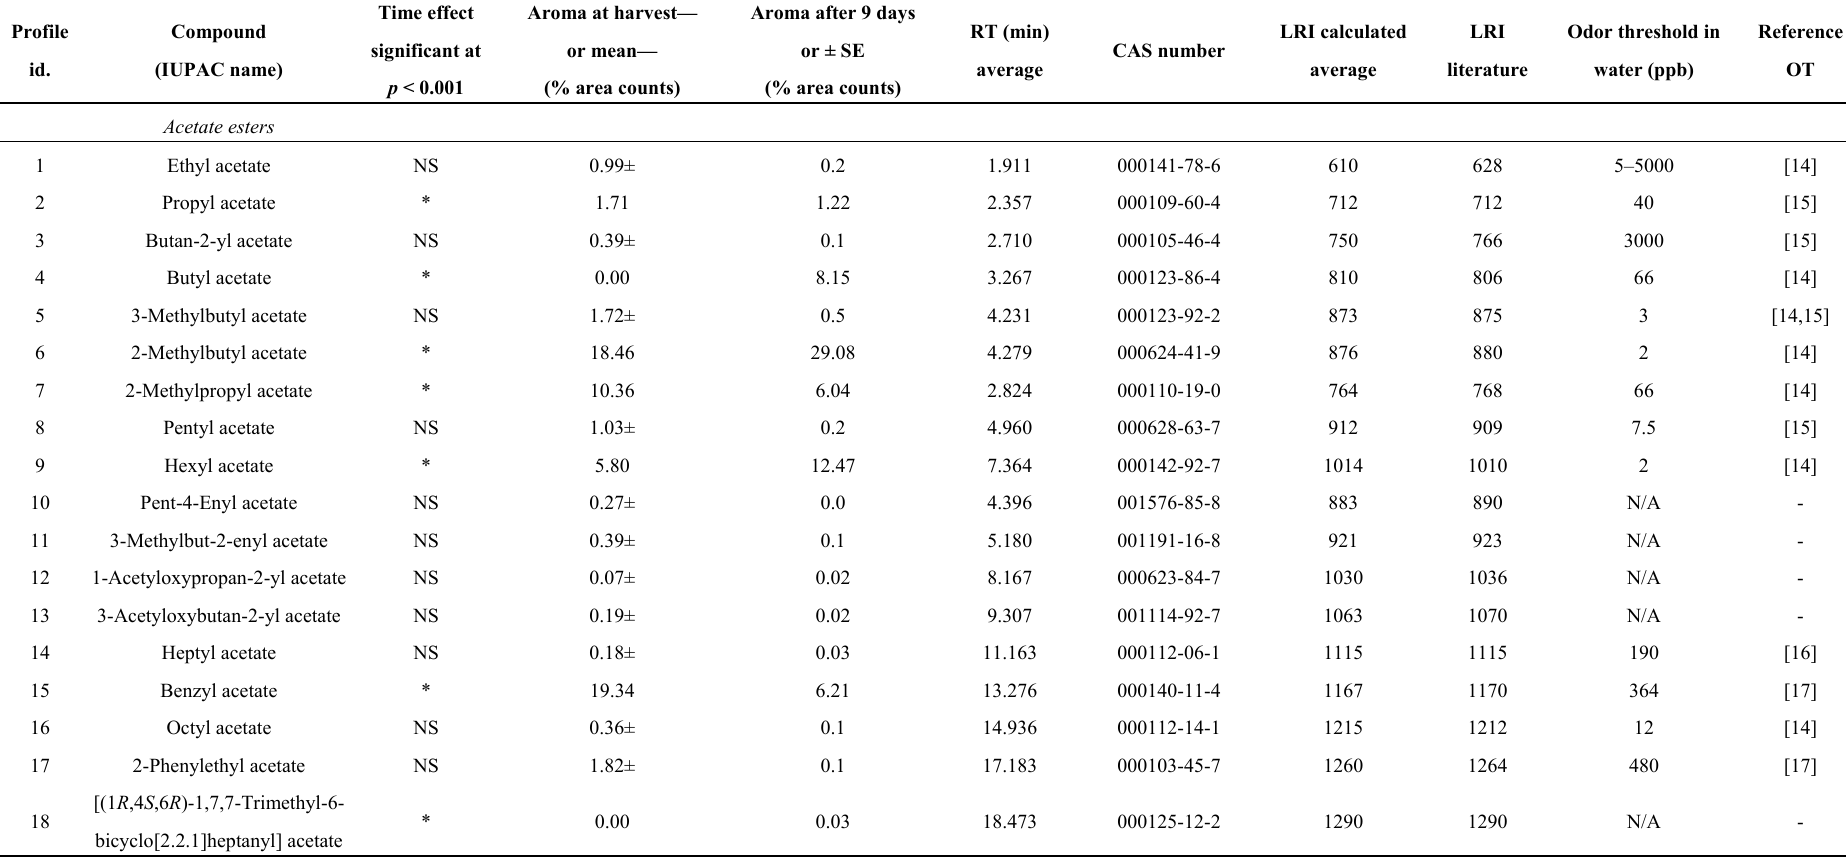
Table 1. Aroma volatile profile and concentration (average of relative area percentage on a total peak area basis) of compounds detected by headspace stir-bar sorptive extraction (1 h) during ripening at 21 ± 1 °C and 93% ± 3% relative humidity of intact fruit of near-isogenic line SC3-5-1 (mean ± SE, n = 4). Means ± SE during ripening or mean at harvest or at the climacteric (average of 8 and 10 day of measurement). NID, unidentified; IUPAC, international union of pure and applied chemistry; RT, retention time; CAS, Chemical Abstracts Service (NIST); LRI, linear retention index calculated from the RT of a series of straight-chain alkanes (C6–C20) or obtained from the literature; OT, odor